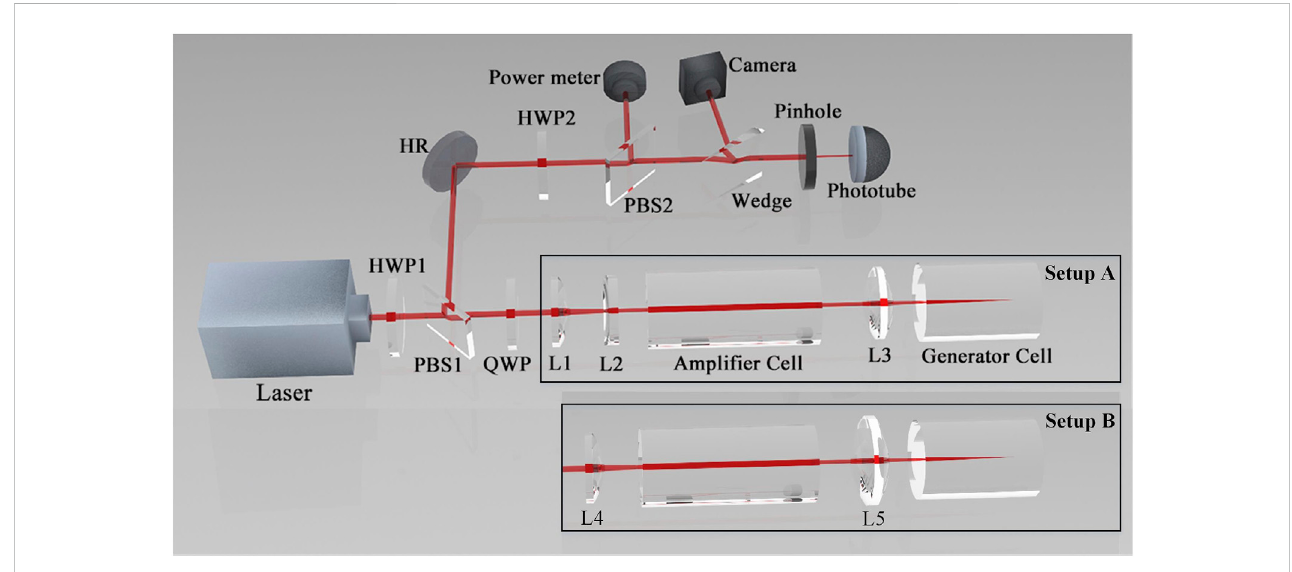
FIGURE 1 Schematic of experimental setups for compact double-cell SBS compressor. QWP, quarter wave plate; HWP1~2, half wave plate; L1~5, lens. In setup A, the input beam is introduced into the SBS ampli fi er cell through a QWP and a pair of lenses L1 and L2 and focused into the generator cell through a lens L3. In setup B, the input beam is introduced into the SBS ampli fi er cell through a QWP and a lens L4 and focused into the generator cell through a focusing lens